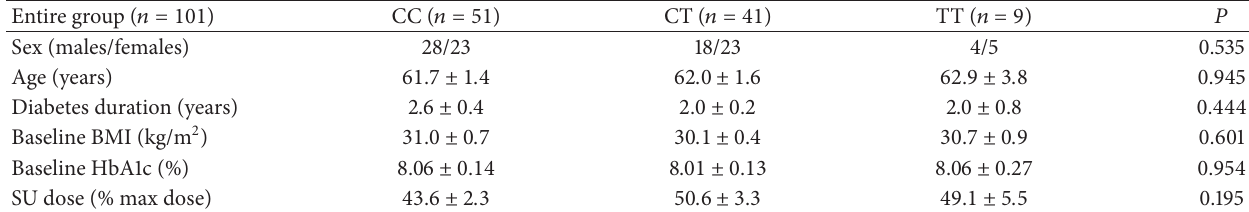
Table 2: Baseline characteristics across TCF7L2 rs7903146 genotypes in the entire group.